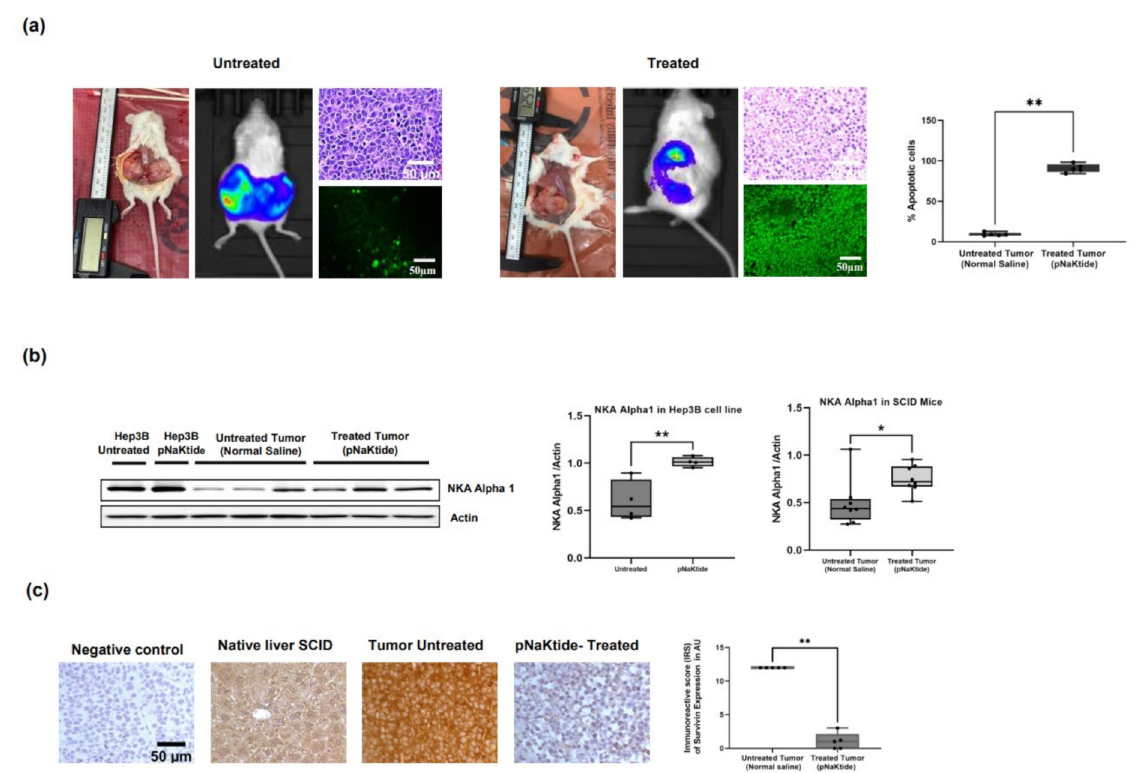
Figure 4. Effect of α 1-Na/K-ATPase signalosome normalization on SCID mice xenograft tumor cells. ( a ) Representative images of tumors from untreated vs. pNaKtide treated SCID mice xenograft tumors. Tumor sizes were assessed via the use of video-IVS method and electronic calipers measurement. Representative images of H&E staining of tumor sections from untreated and treated mice are also shown ( top ). Additionally, representative confocal images of apoptosis in untreated vs. pNaKtide treated tumor are shown ( bottom ). Notice, the difference in tumor cells histology and heightened apoptosis in the treated tumor vs. untreated tumor ( n = 5. ** p < 0.01, t -test). ( b ) Increase α 1- Na/KATPase expression in the xenograft tumors of the treated mice compared with the untreated mice ( n = 8, * p < 0.05, ** p < 0.01, t -test). ( c ) Survivin expression in pNaKtide-treated tumors vs. untreated tumors. Survivin expression was significantly down regulated in the treated mice tumors in comparison with the untreated mice ( n = 5. ** p < 0.01, t